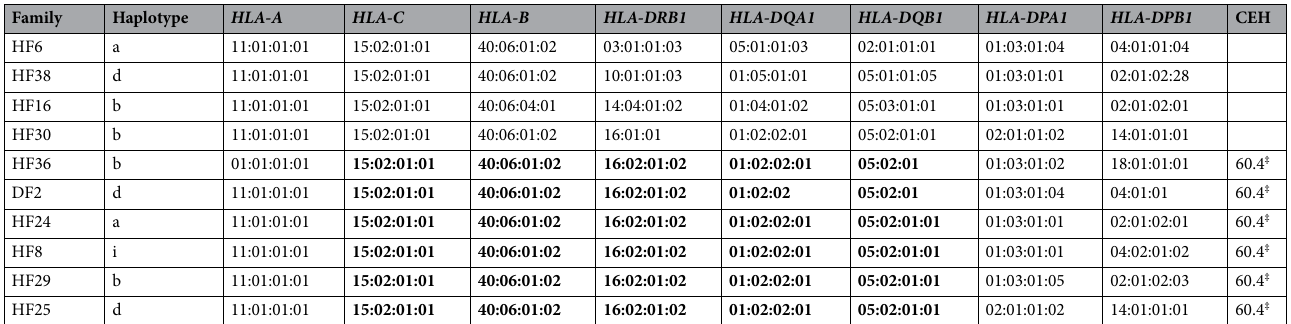
Table 8. MHC haplotypes of UAE families marked by HLA-B*40:06. The group of alleles that make up the designated CEH in column “CEH” are denoted in bold. ‡